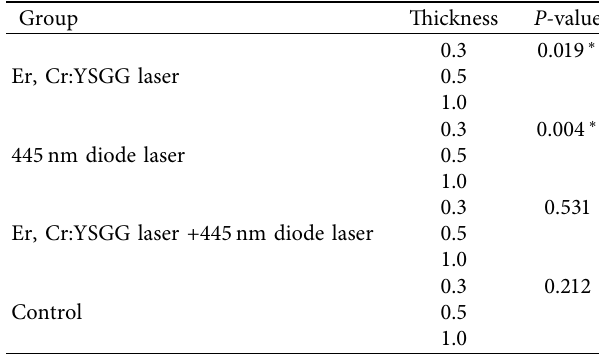
Table 3: Comparison of the number of bacteria in different thicknesses for each group.